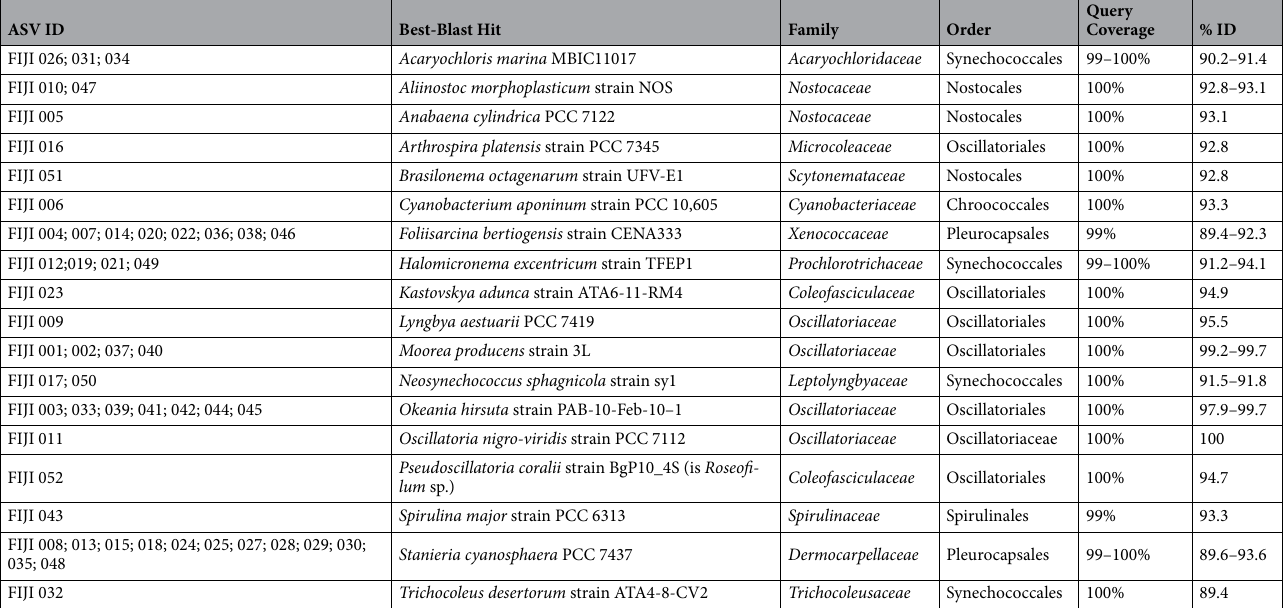
Table 2. Best-blast hits of ASVs (with family and order) that occurred > 1% in at least one of the samples with percentage of query coverage and percentage identity (ID). E-value < 1 E-131.The ASV ID is the code given to the different ASVs which can also be found in the phylogenetic tree (Fig.